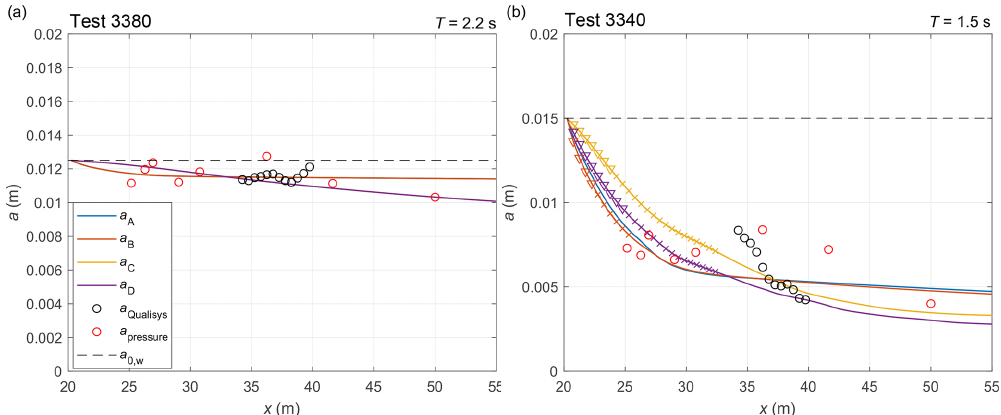
Figure 7. Amplitude of the vertical ice deflection along the tank in two selected tests from series 3000: 3380 (a) and 3340 ( b ; for analogous plots for all tests from series 3000, see Fig. S4). The measured amplitude is shown with red (pressure sensors) and black (Qualisys) circles. The black dashed lines show the wave-maker amplitude a 0 , w . The remaining lines show DEM results obtained with set-ups A–D (see Table 2). Locations with overwash are marked with crosses, and those where the change of wave amplitude due to overwash from one floe to the next exceeds 1mm are marked with